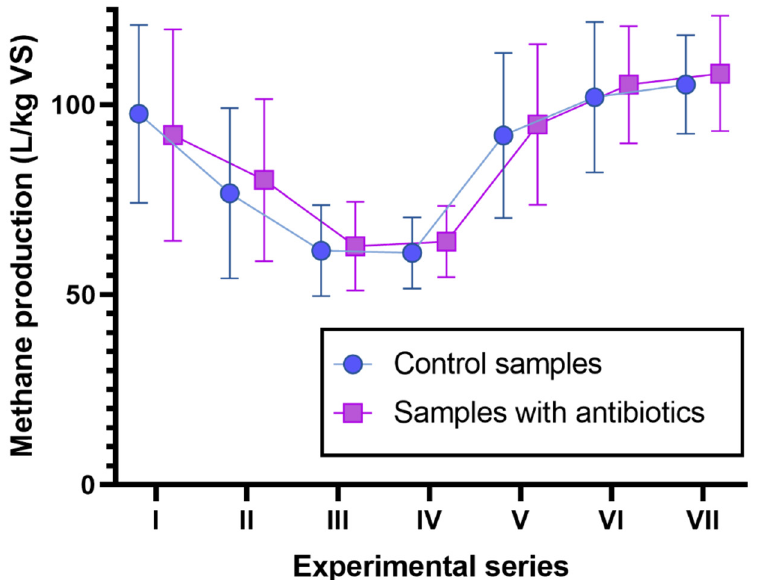
Figure 1. Methane production in seven experimental series (L/kg VS). The presented data are the average values in each experimental series with triplicate measurements and two replicates. Error bars represent standard deviation (SD).